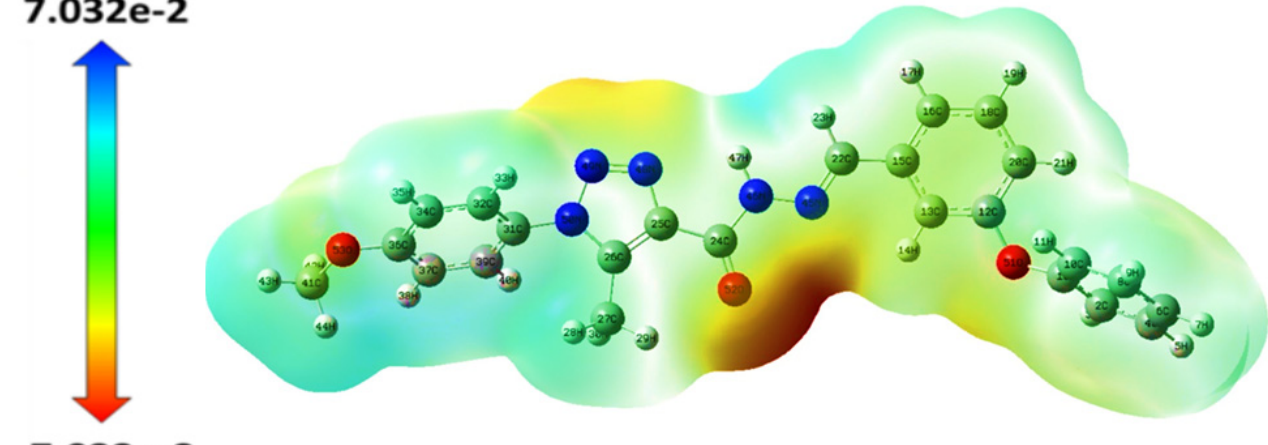
Figure 3. The graphical representation showing hydrogen bonding and motif ( R 2 (13) ) in the crystal structure of 2 . Atoms O2, H13, C13, C17, N3, and H17C refer to one pair of molecules, whereas O5, H37, C37, C41, H41C, and N8 refer to another pair.